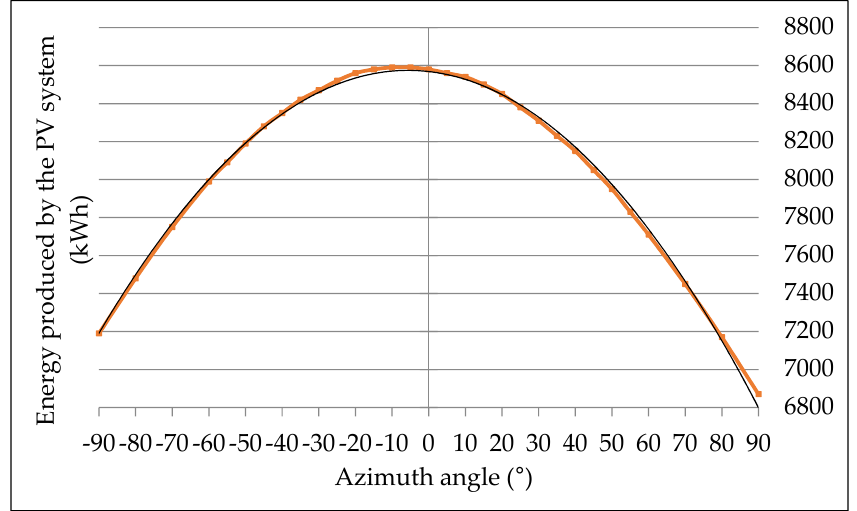
Figure 13. Relation between the PV system energy production and the azimuth angle.